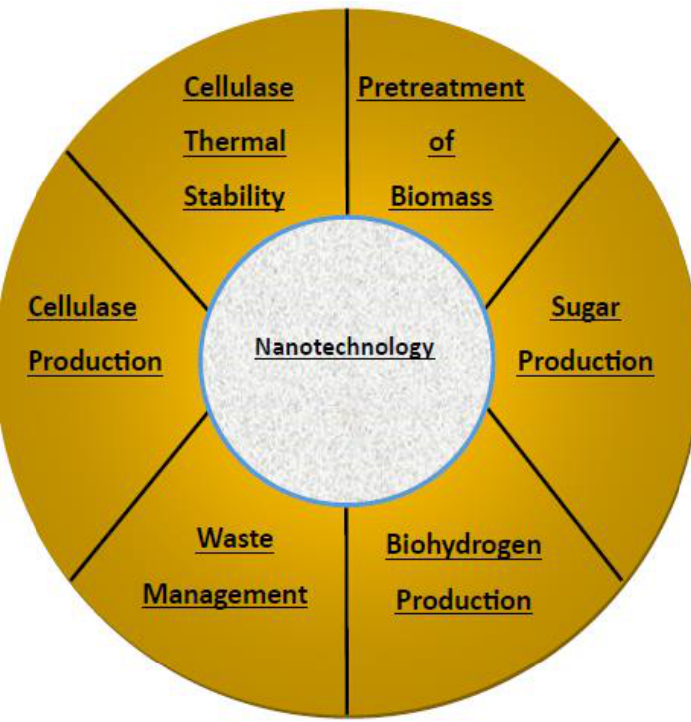
Figure 3. Various applications of nanotechnology.